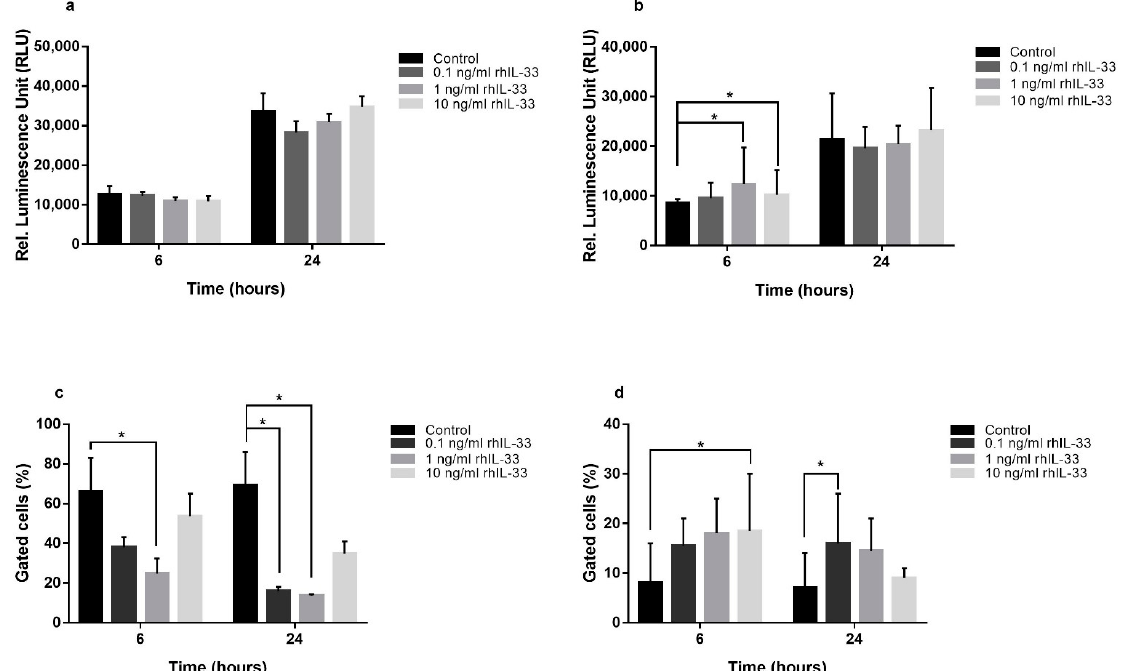
Figure 4. Exogenous treatment with rhIL-33 is able to modulate apoptosis. Quantitation of relative luminescence unit (RLU) for caspase 3/7 activity and the percentage of annexin-V-positive cells by cytofluorimetric assay show a reduction in early apoptosis in GES-1 ( c ) without variation in the activation of executioner caspases ( a ). In AGS, the same treatment increased both executioner caspases ( b ) and early apoptosis ( d ). Data are shown as mean ± SD. * p < 0.05.